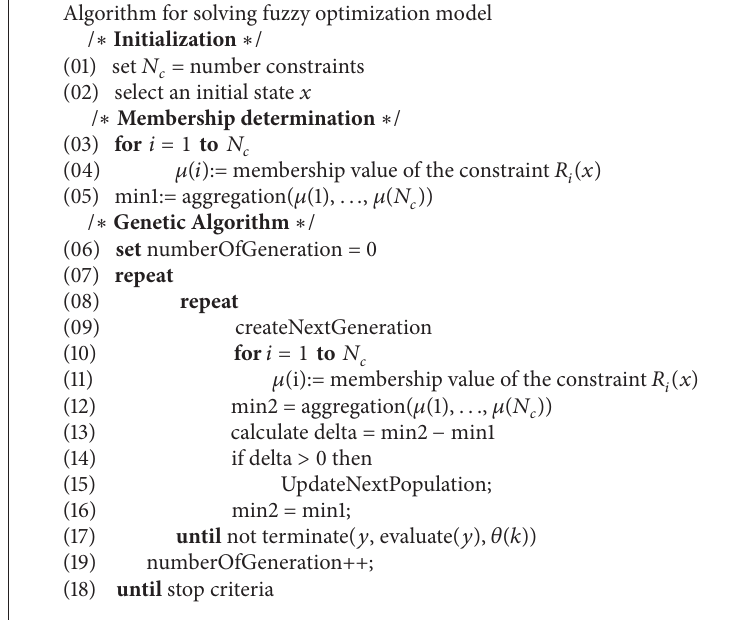
Algorithm 1: Genetic algorithm pseudocode for maxmin